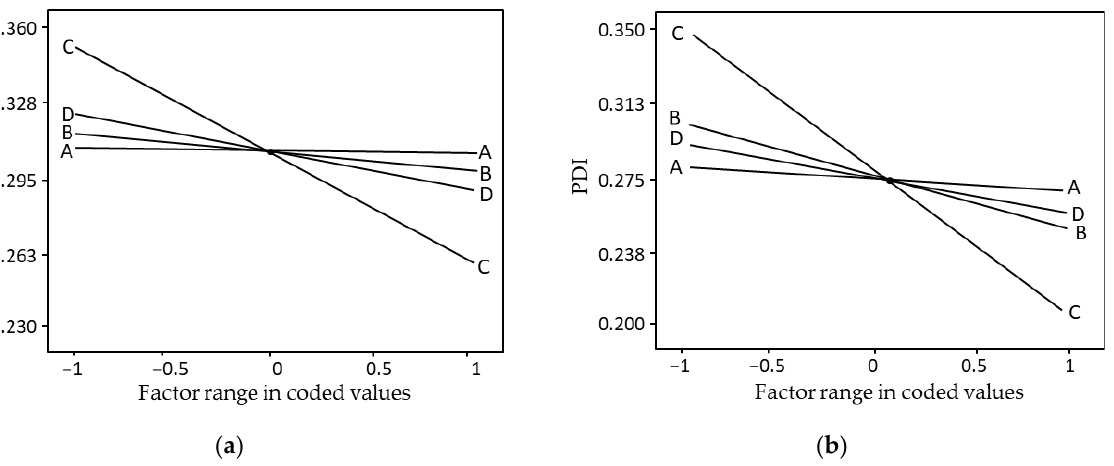
Figure 3. One factor plot of ( a ) DTX-loaded nanoemulsion and ( b ) CCM-loaded nanoemulsion on the response variable of PDI. A: Overhead stirrer speed (rpm); B: Overhead stirrer duration (min); C: High shear speed (rpm); D: High shear duration (min); PDI: Polydispersity index.